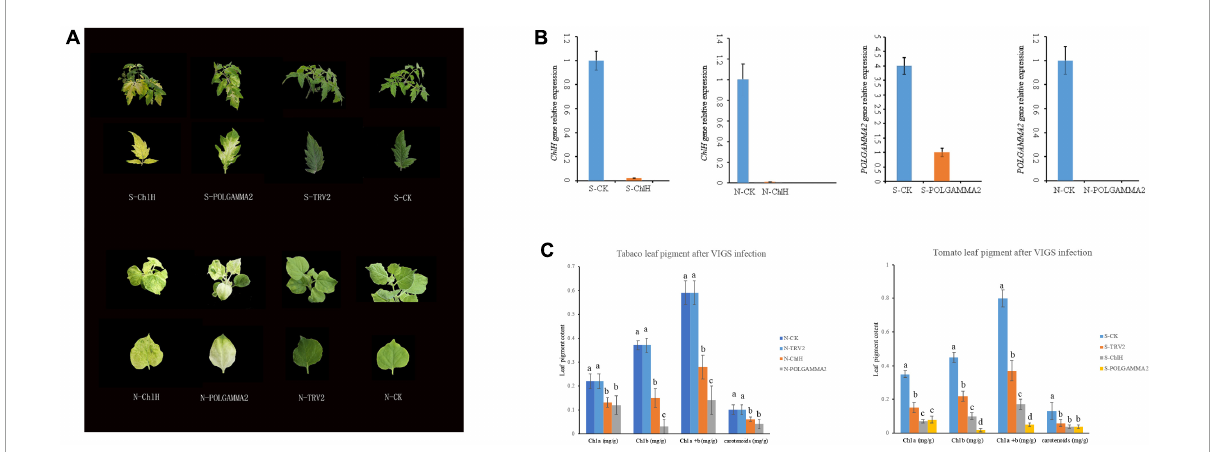
FIGURE4 The leaf color change in tobacco and tomato plants after transiently silencing candidate genes. (A) The leaf color of ChlH -silenced (S/N-ChlH), POLGAMMA2 -silenced (S/N-POLGAMMA2), TRV2 (vector control; S/N-TRV2), and non-infected (S/N-CK) tomato (S-) and tobacco (N-) plants. (B) The relative gene expression of ChlH and POLGAMMA2 in ChlH -silenced and POLGAMMA2 -silenced tomato (S-) and tobacco (N-) plants, respectively. (C) The content of Chl a , Chl b , total Chl, and carotenoid in CK, TRV2, ChlH -silenced, and POLGAMMA2 -silenced tomato (S-) and tobacco (N-) plants.